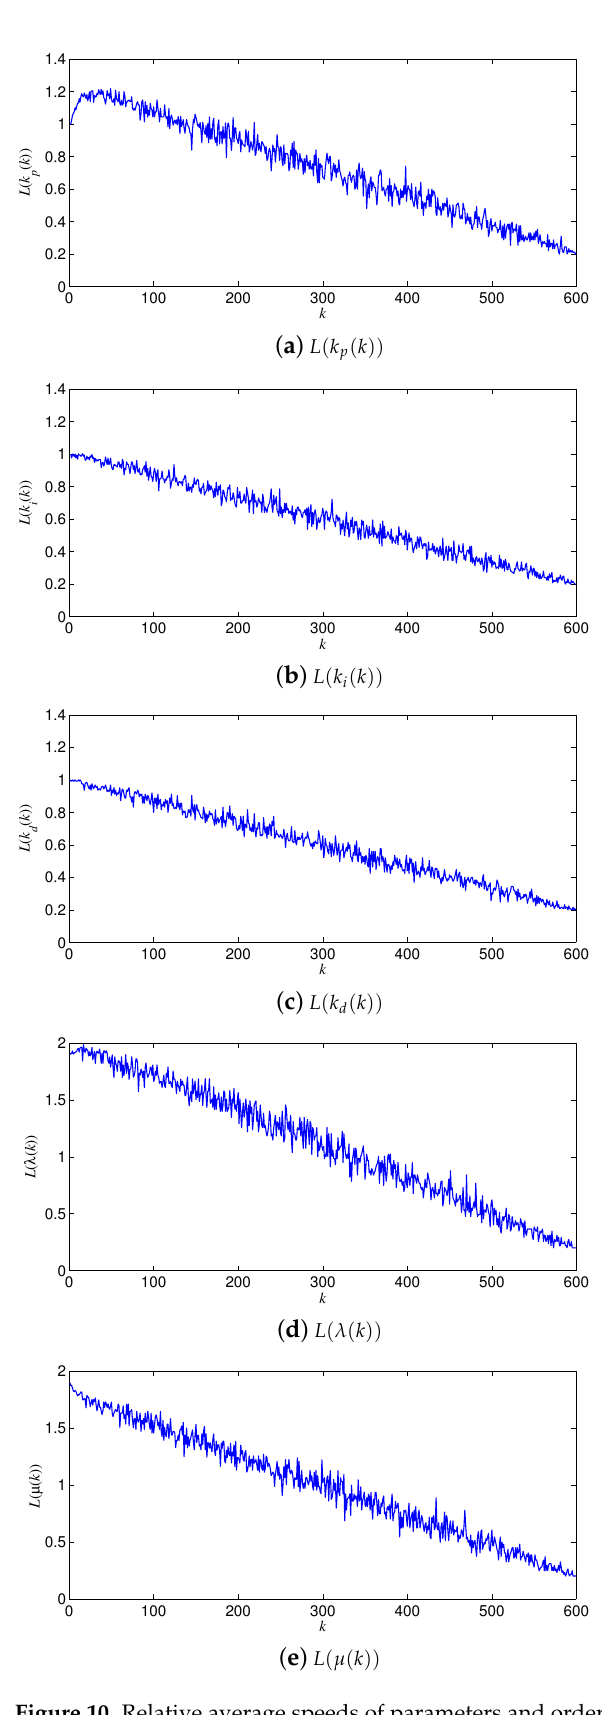
Figure 10. Relative average speeds of parameters and